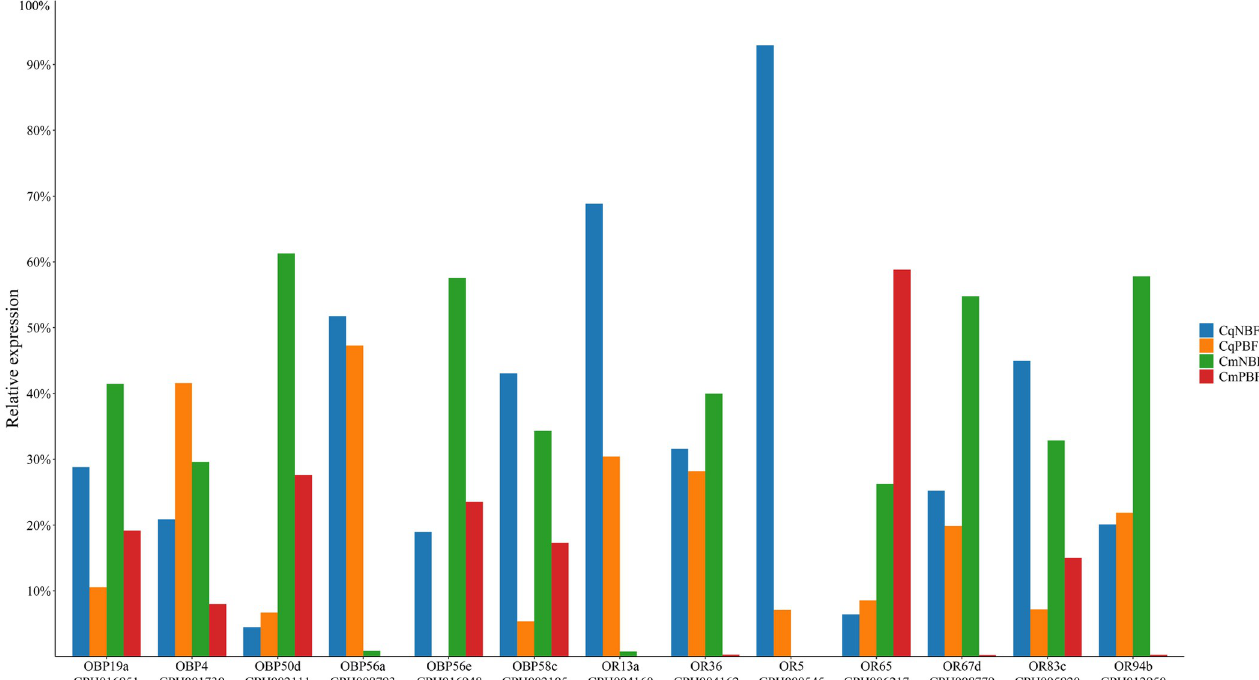
Fig 4. Quantitative PCR validation results for significantly different olfactory genes. The column represents the relative expression ratio; the total of the 4 columns for each individual gene should total 100%.